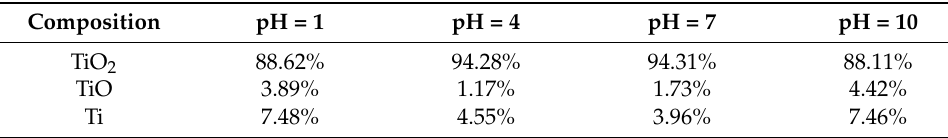
Table 4. The composition of the TA2 passive film formed under different pH